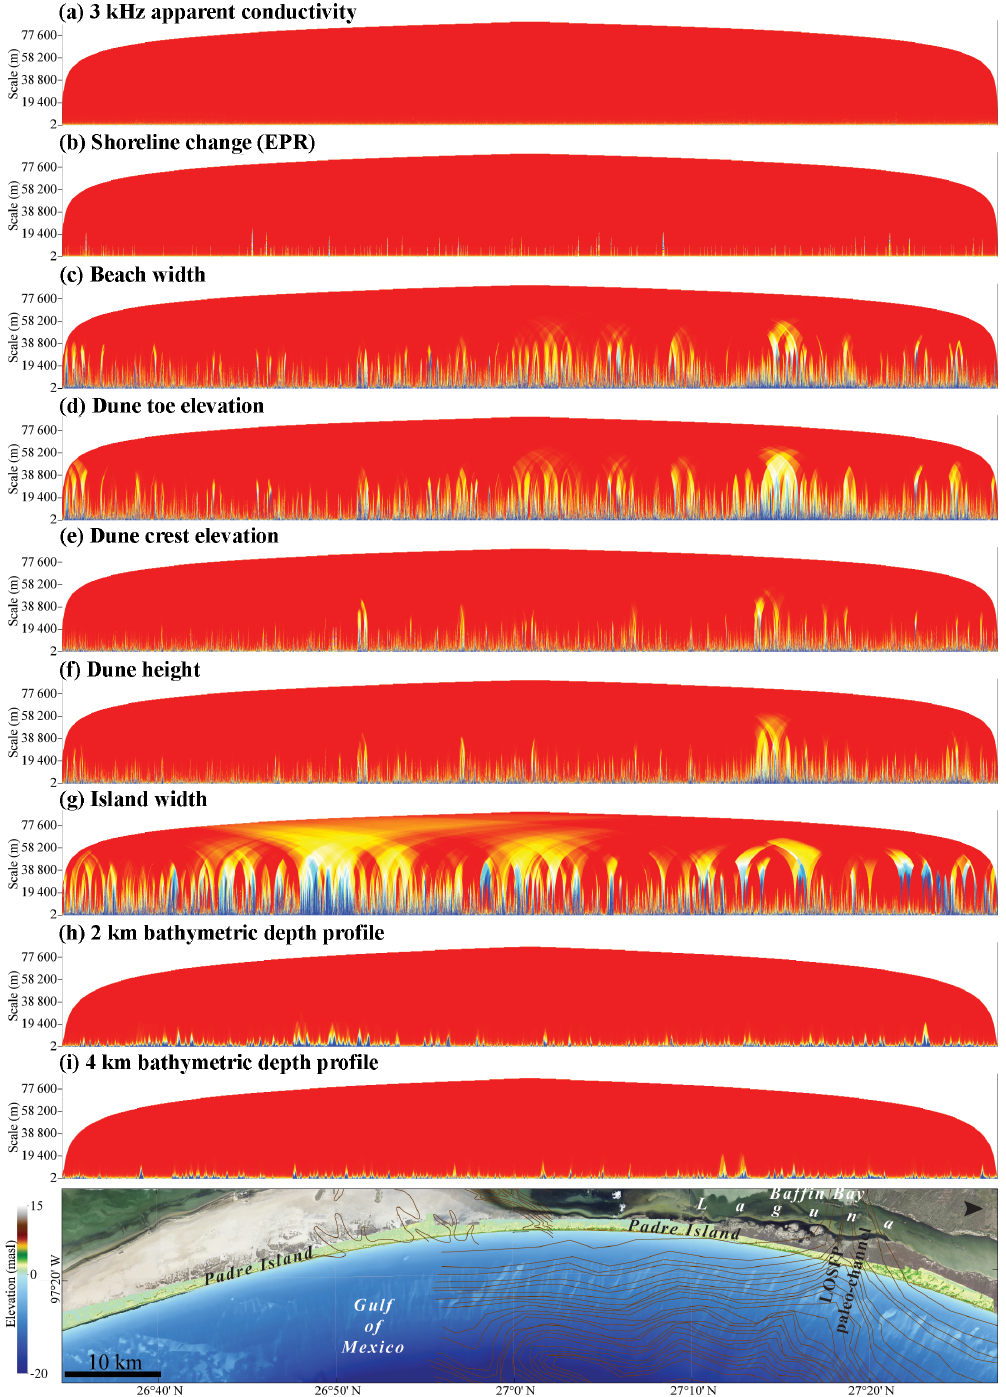
Figure 4. Long-range dependence plots of alongshore morphometrics: (a) 3kHz apparent conductivity, (b) shoreline change rate (end-point rate), (c) beach width, (d) dune toe elevation, (e) dune crest elevation, (f) dune height, (g) island width, (h) bathymetric depth profile at 2km offhsore, and (i) bathymetric depth profile at 4km offshore. All LRD plots are aligned with the map below, based on latitude. Previously documented variability in the framework geology is indicated by the contour lines representing the Pleistocene (i.e., MIS II) paleo-surface (Anderson et al., 2016; Fisk,